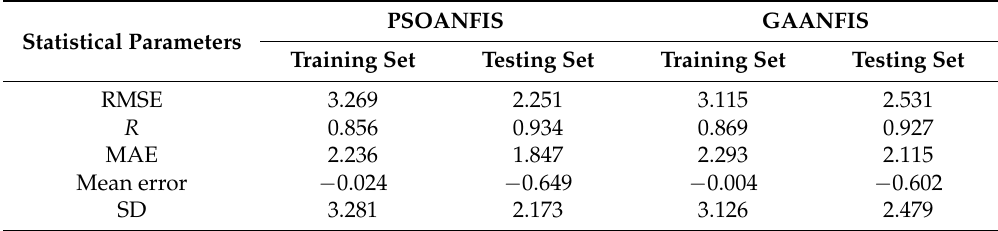
Figure 9. Mean errors and standard deviations of different models: ( a ) training PSOANFIS, ( b ) testing PSOANFIS, ( c ) training GAANFIS, and ( d ) testing GAANFIS. Table 5. Validation results of the two proposed models.